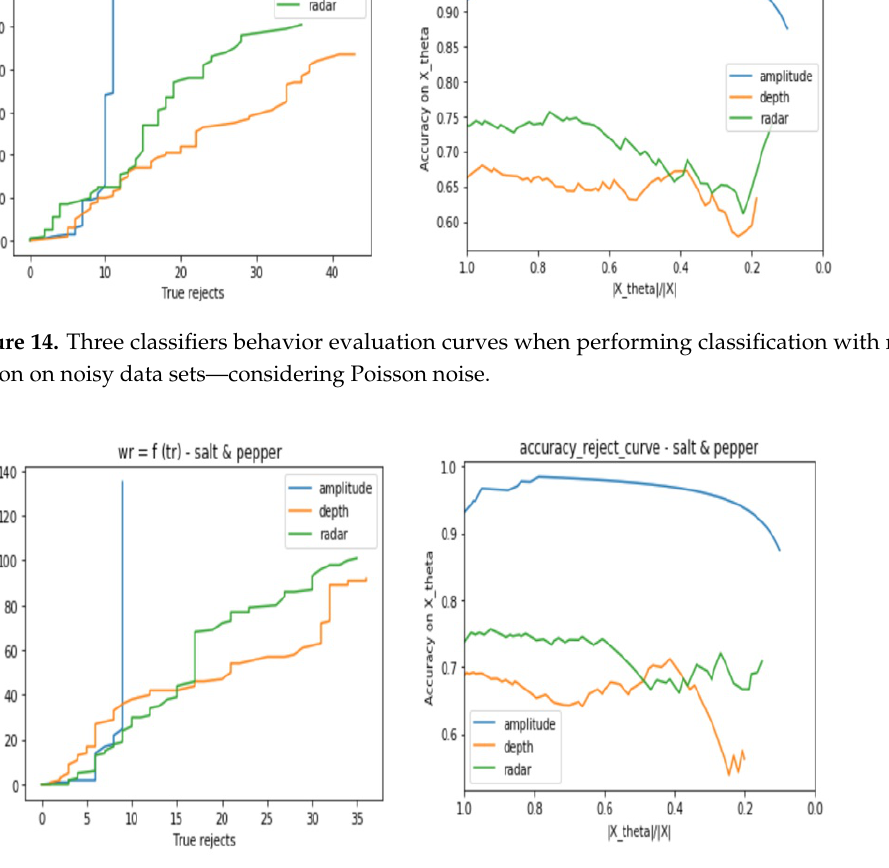
Figure 15. Three classifiers behavior evaluation curves when performing classification with reject option on noisy data sets—considering Salt and Pepper